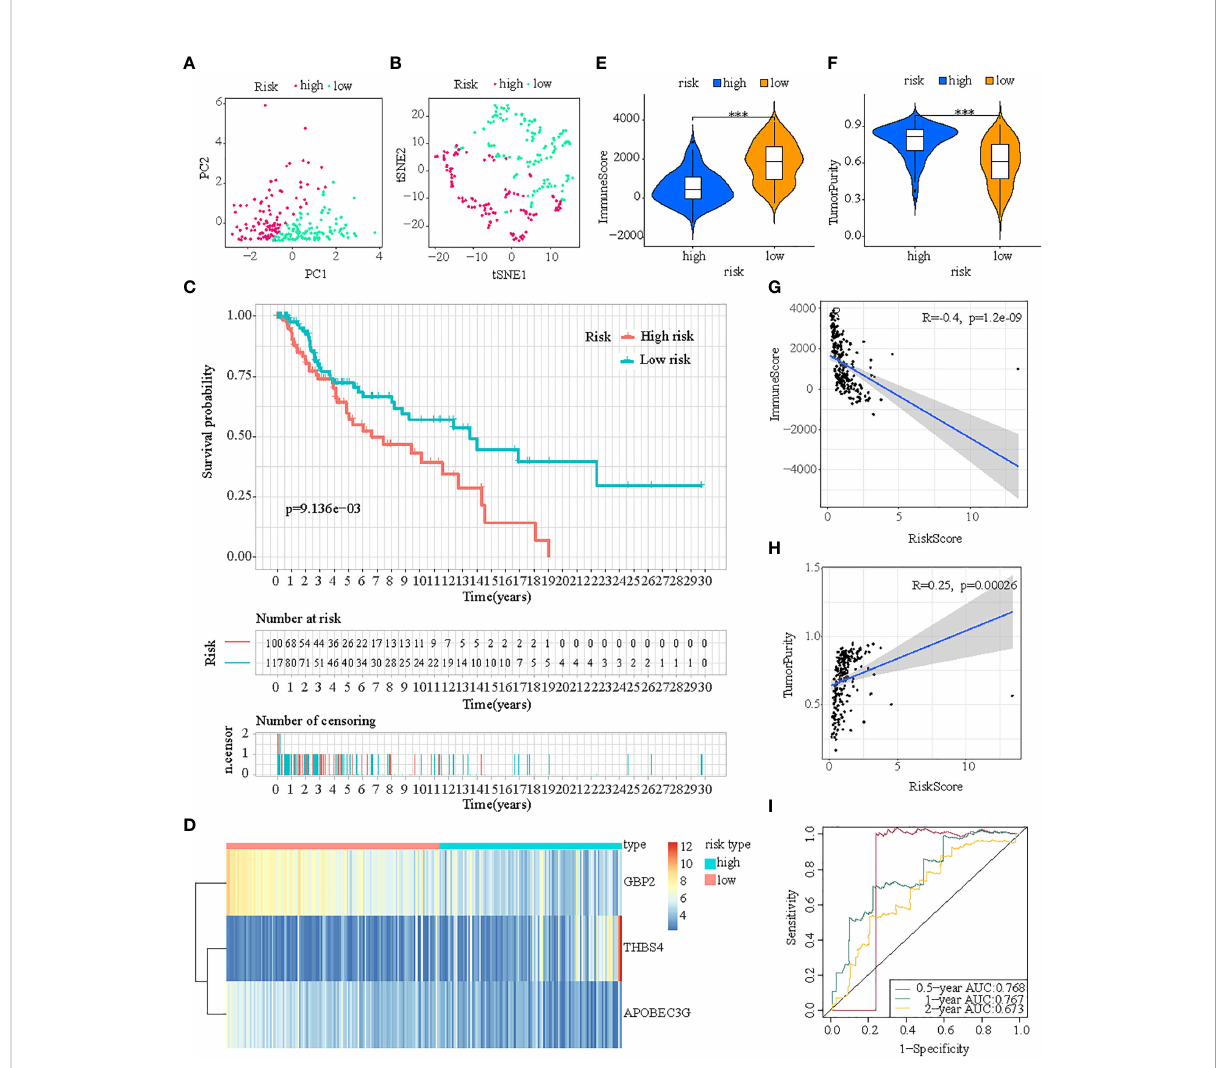
FIGURE 5 Internal veri fi cation of ICDRS in test1 cohort. (A, B) PCA and t-SNE analysis illustrated an excellent clustering performance of the ICDRS-based risk score; (C) Kaplan – Meier survival curves for the overall survival of two risk groups in the test1 cohort; (D) Distribution pattern of the expression levels of the 3 genes in the test1 cohort; (E, F) Comparing TME components in test1 cohort (*** indicates p < 0.001); (G) The correlation between ImmuneScore and risk score; (H) The correlation between TumorPurity and risk score; (I) AUC values of 0.5-, 1-, and 2- year in the test1